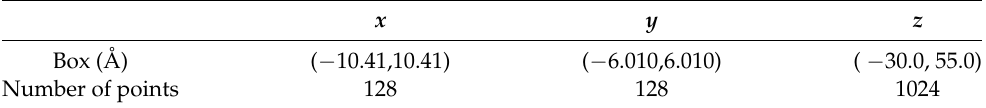
Table A1. Grid sizes and number of points for the representation of the wave packet. Grid boxes for the parallel coordinates correspond to those of the unit cell of Figure 1a of the main text.